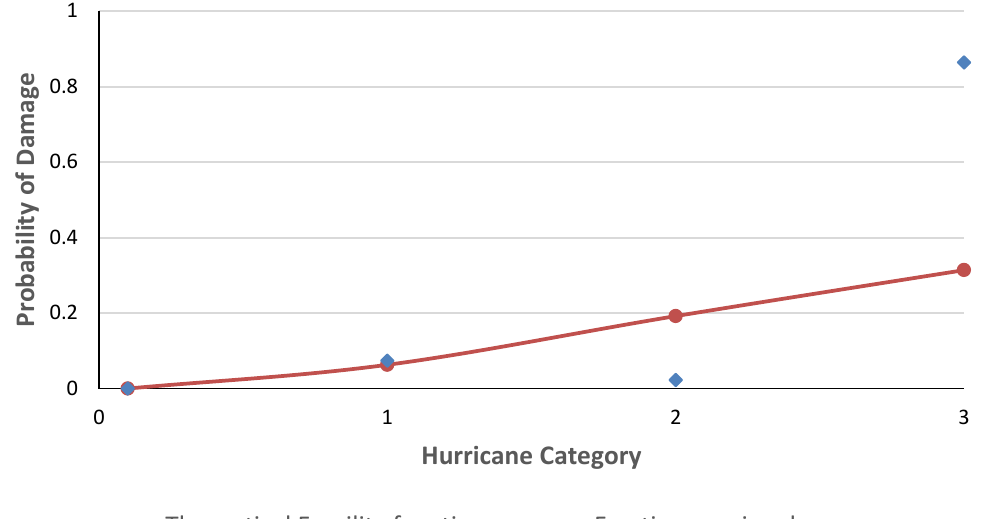
Figure 4. Historical damage records for signs damaged based on hurricane categories in Florida.